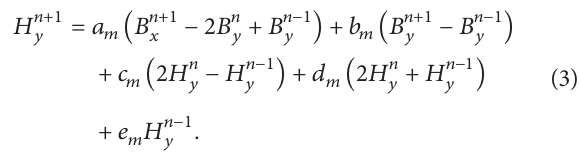
Figure 1: Yee’s arrangement of field components in a cubic lattice